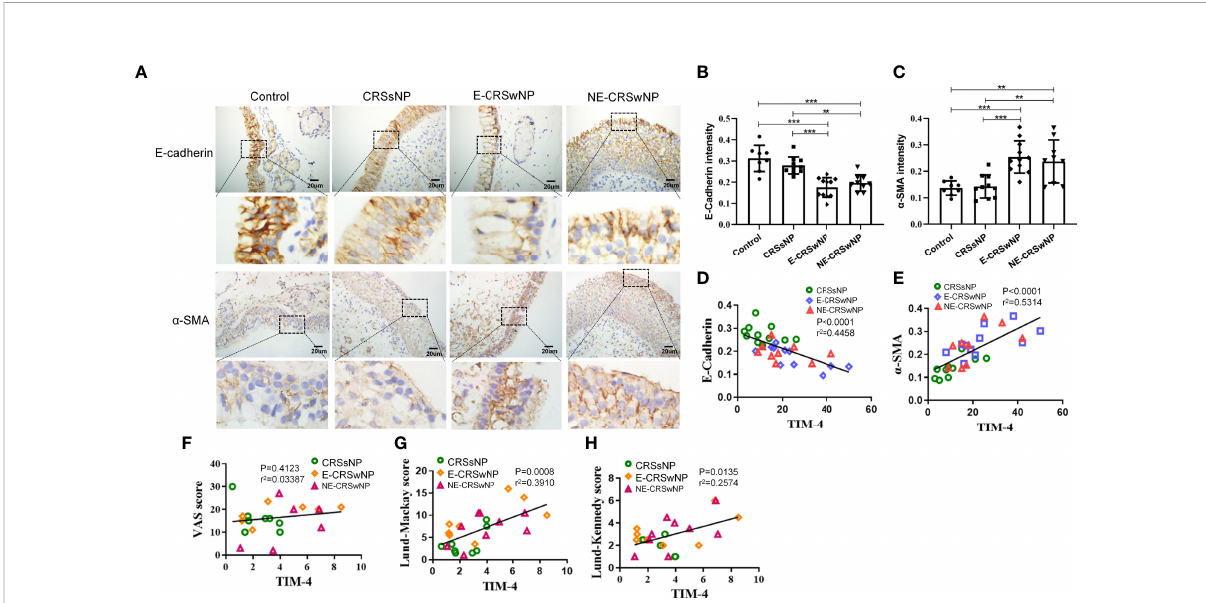
FIGURE 2 Correlation analysis between TIM-4 and EMT markers in patients with CRS. (A-C) The expression of the EMT markers E-cadherin and a -SMA in different human sinonasal mucosal tissues. (A) Images show the representative immunostaining of E-cadherin and a -SMA in the sinonasal mucosa of healthy individuals and CRSsNP, E-CRSwNP, and NE-CRSwNP patients by IHC (control group: n=8; CRSsNP group: n=11; E-CRSwNP group: n=11; NE-CRSwNP group: n=9). (B, C) Quantitative summary of the intensity of E-cadherin (B) and a -SMA (C) in the human sinonasal mucosa. (D, E) The correlation between TIM-4 and EMT markers E-cadherin and a -SMA. (F-H) The correlation between TIM-4 and the clinical parameters of VAS score, Lund – Mackay score and Lund – Kennedy score. The Pearson correlation test was used, and r 2 represents the coef fi cient of determination. All of the above representative pictures are shown at a magni fi cation of 400×. Bars show the mean ± SD. **P<0.01,